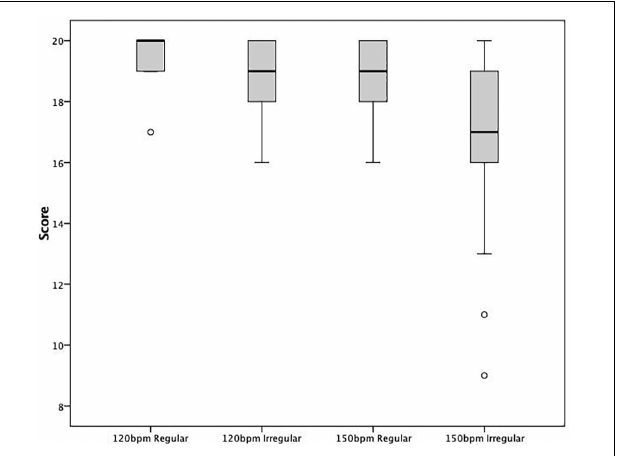
FIGURE 2 | The distribution of scores across all conditions of the peg tapping task